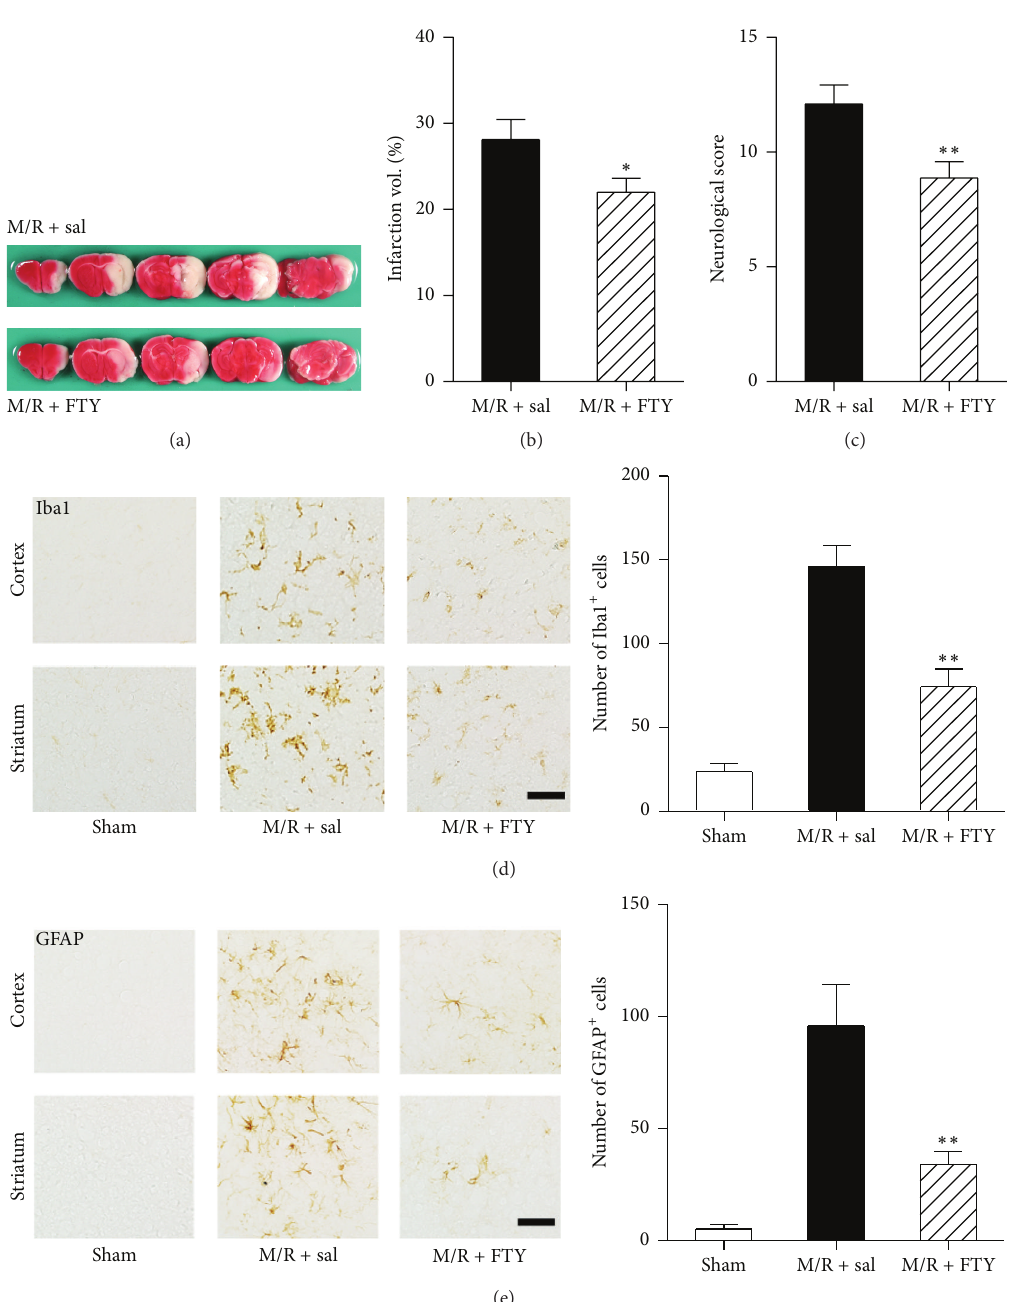
Figure 4: FTY720 reduces brain damage and neuroinflammation in M/R-challenged mice. Mice were challenged by 90 min occlusion and braininfarctionorneuroinflammationwasassessed22 hafterreperfusion.FTY720(FTY,3 mg/kg,i.p.)wasadministeredtomiceimmediately after reperfusion. (a) Representative TTC-stained brain slices of M/R + saline (sal) and M/R + FTY. Photographs are coronal brain sections stained with TTC showing infarct area (white) and intact area (red). (b) Percentage of infarct volumes calculated from the TTC-stained brain slices. Infarct volume was measured using Image J software, and the percentage of infarction was assessed. (c) Neurological score demonstrating neurological functions. ∗ 𝑃 < 0.05 ( 𝑡 -test), compared with the saline-treated group (M/R + sal) ( 𝑡 -test). 𝑛 = 12 ∼ 15 per group. (d, e) Representative microphotographs of cortex and striatum regions immunolabeled against Iba1 (d) or GFAP (e) and their quantitative analysis in groups of sham, M/R + sal, and M/R + FTY. ∗∗ 𝑃 < 0.01 , compared with the saline-treated group (M/R + sal) of each set (Newman- Keuls test). 𝑛 = 3 per group. Scale bar, 50 𝜇